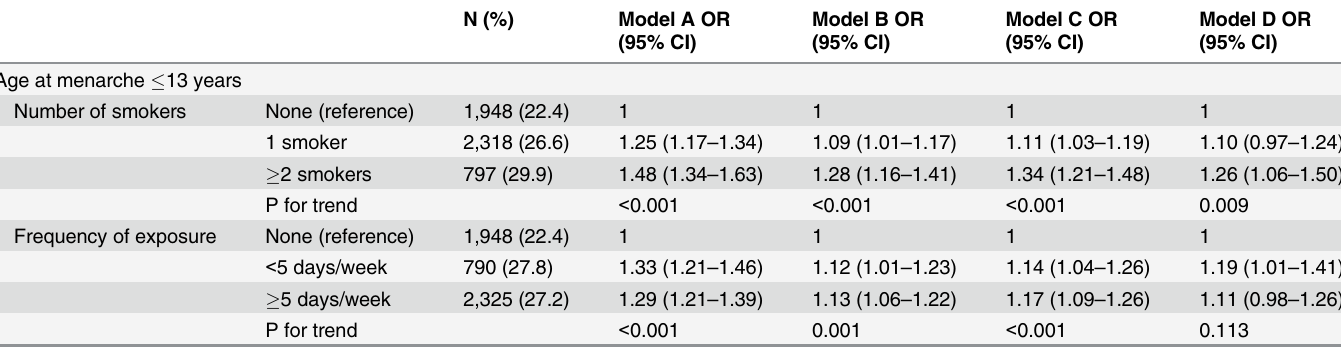
Table 3. Odds ratio (95% CI) of early age at menarche ( (cid:3) 13 years old) for childhood passive smoking exposure in women who have never